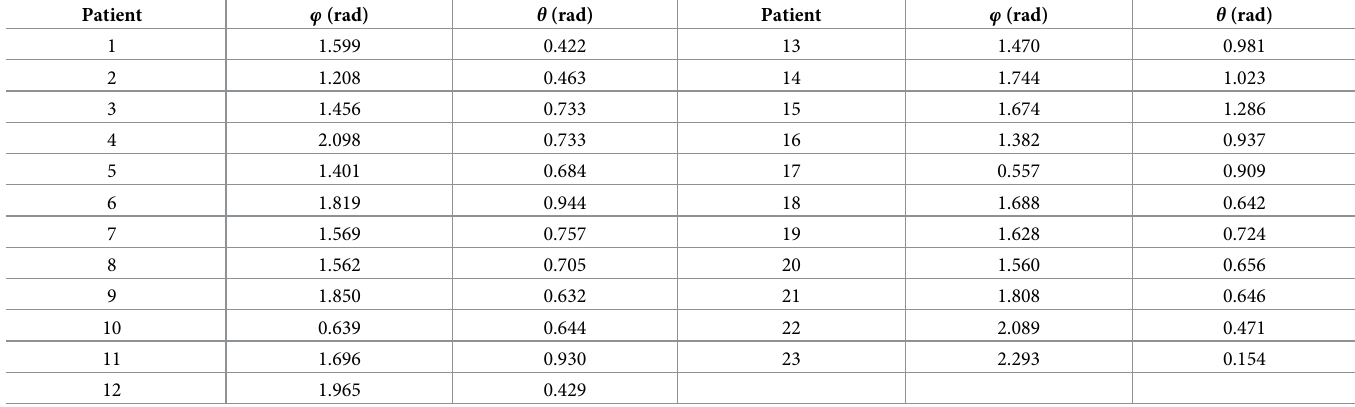
Table 4. The bivariate eye